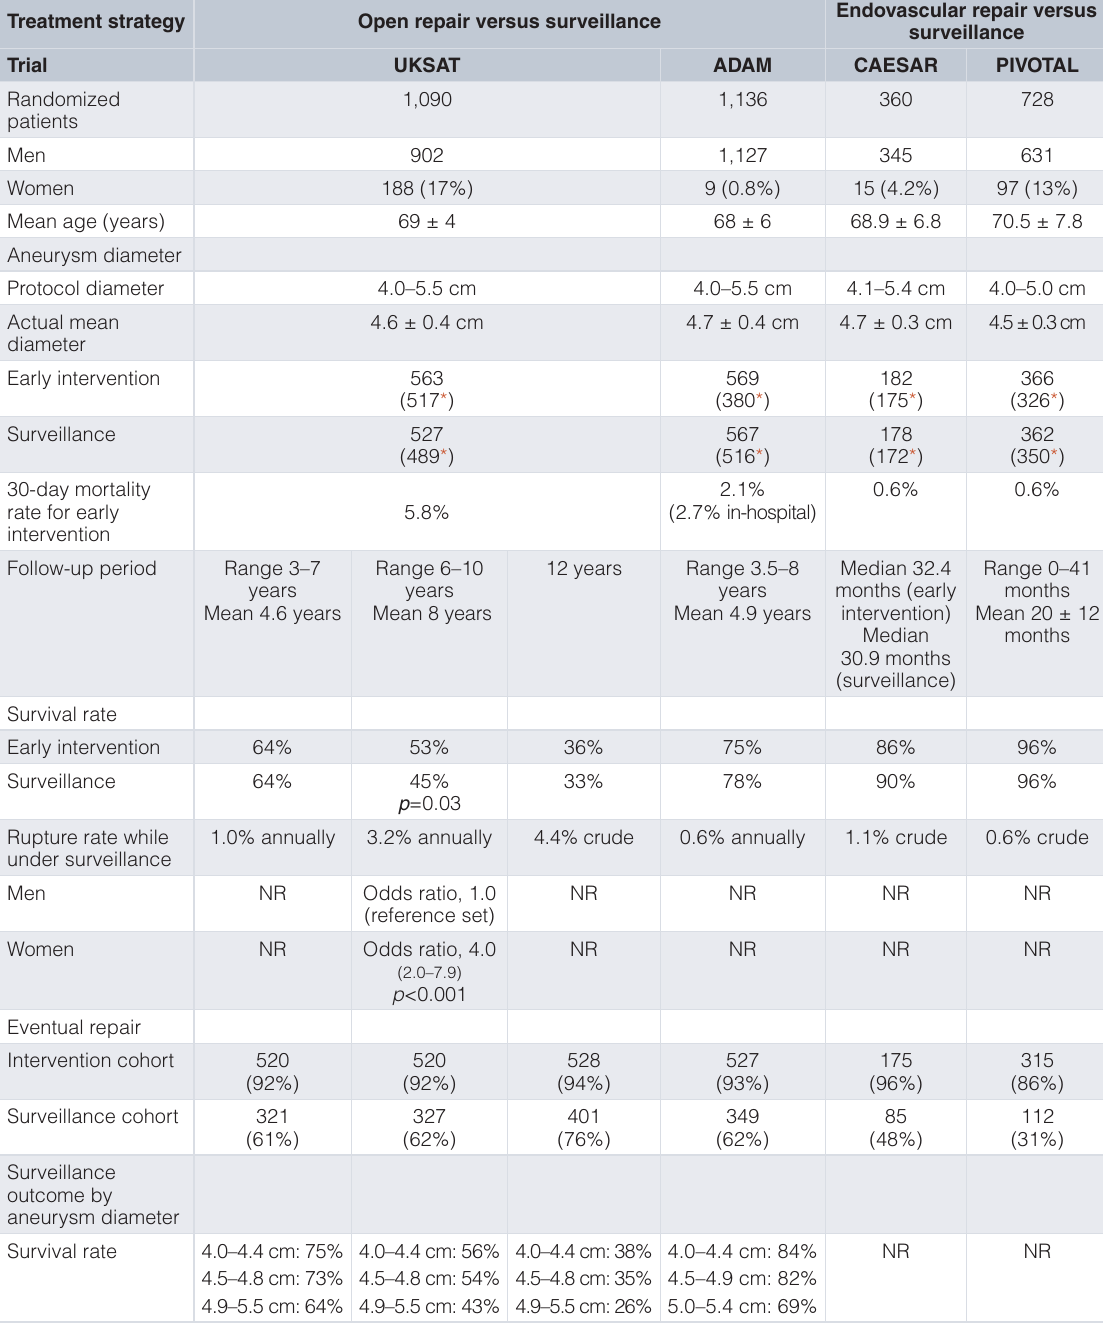
Table 1. Intention-to-treat analysis of early intervention versus ultrasound surveillance for small abdominal aortic aneurysms in the randomized UKSAT 21–23 , ADAM 24 , CAESAR 25 , and PIVOTAL 26